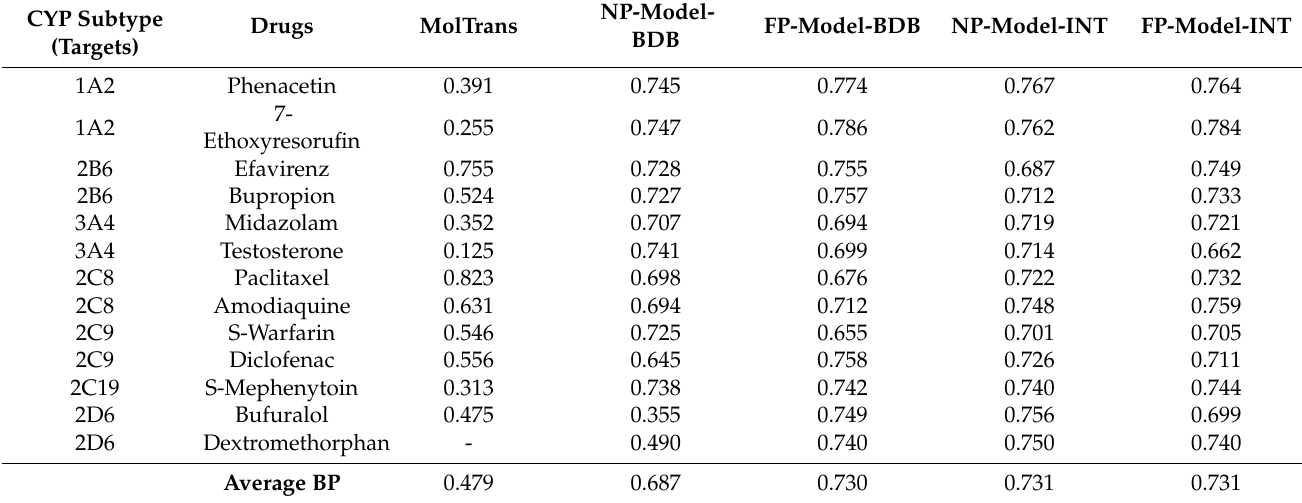
Table 5. Prediction of 13 well-known drug/protein